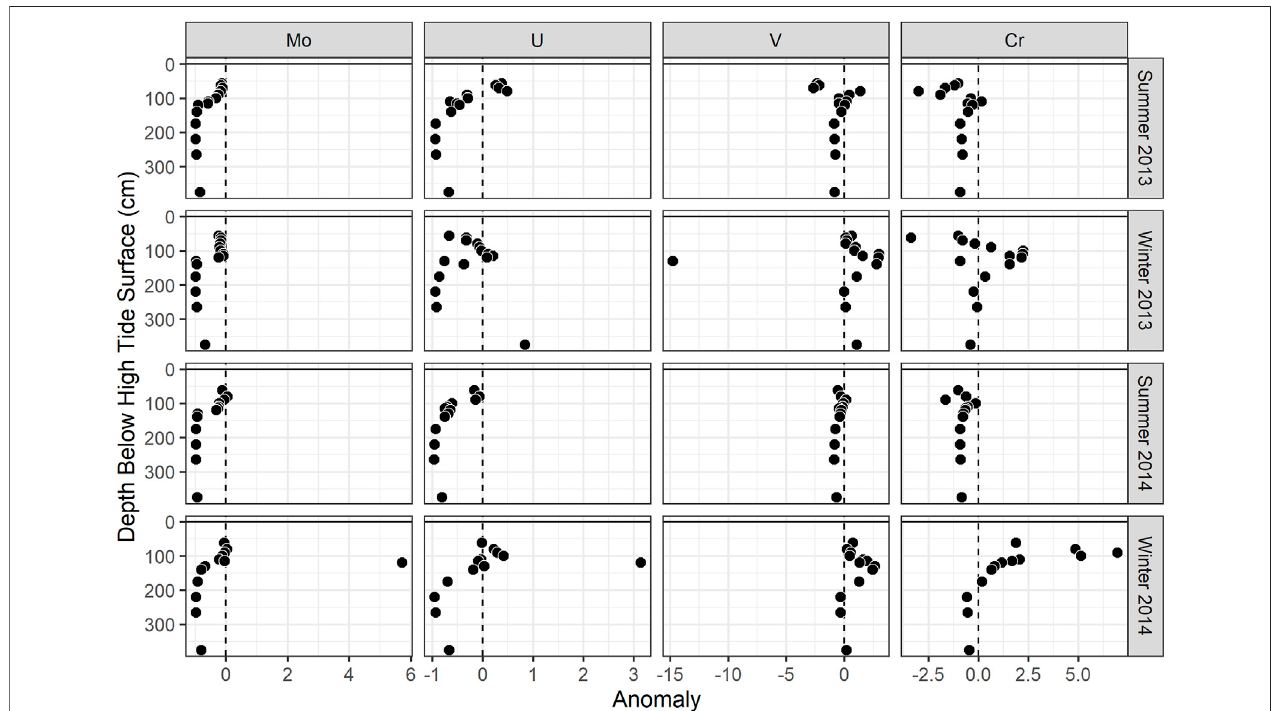
FIGURE 5 | Concentration anomalies (calculated using three endmember mixing as described in the text) of (A) Mo, (B) U, (C) V, and (D) Cr at the MT pro fi le. The points shown are the median anomaly values for each season.